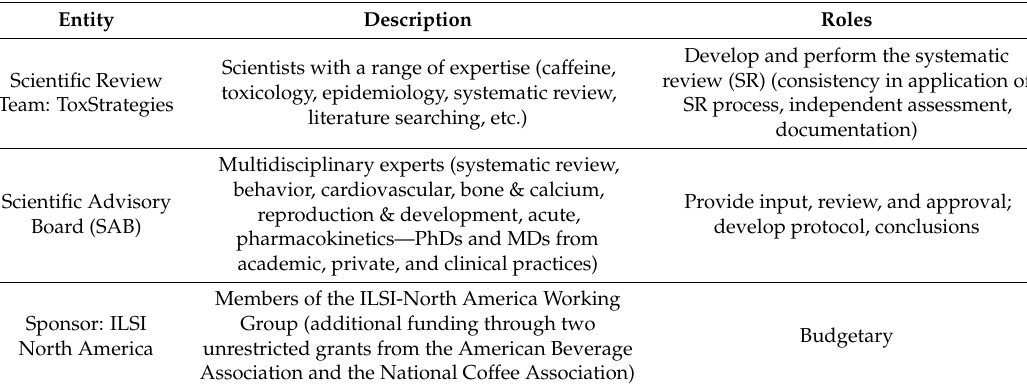
Table 1. Project team and roles for the systematic review.